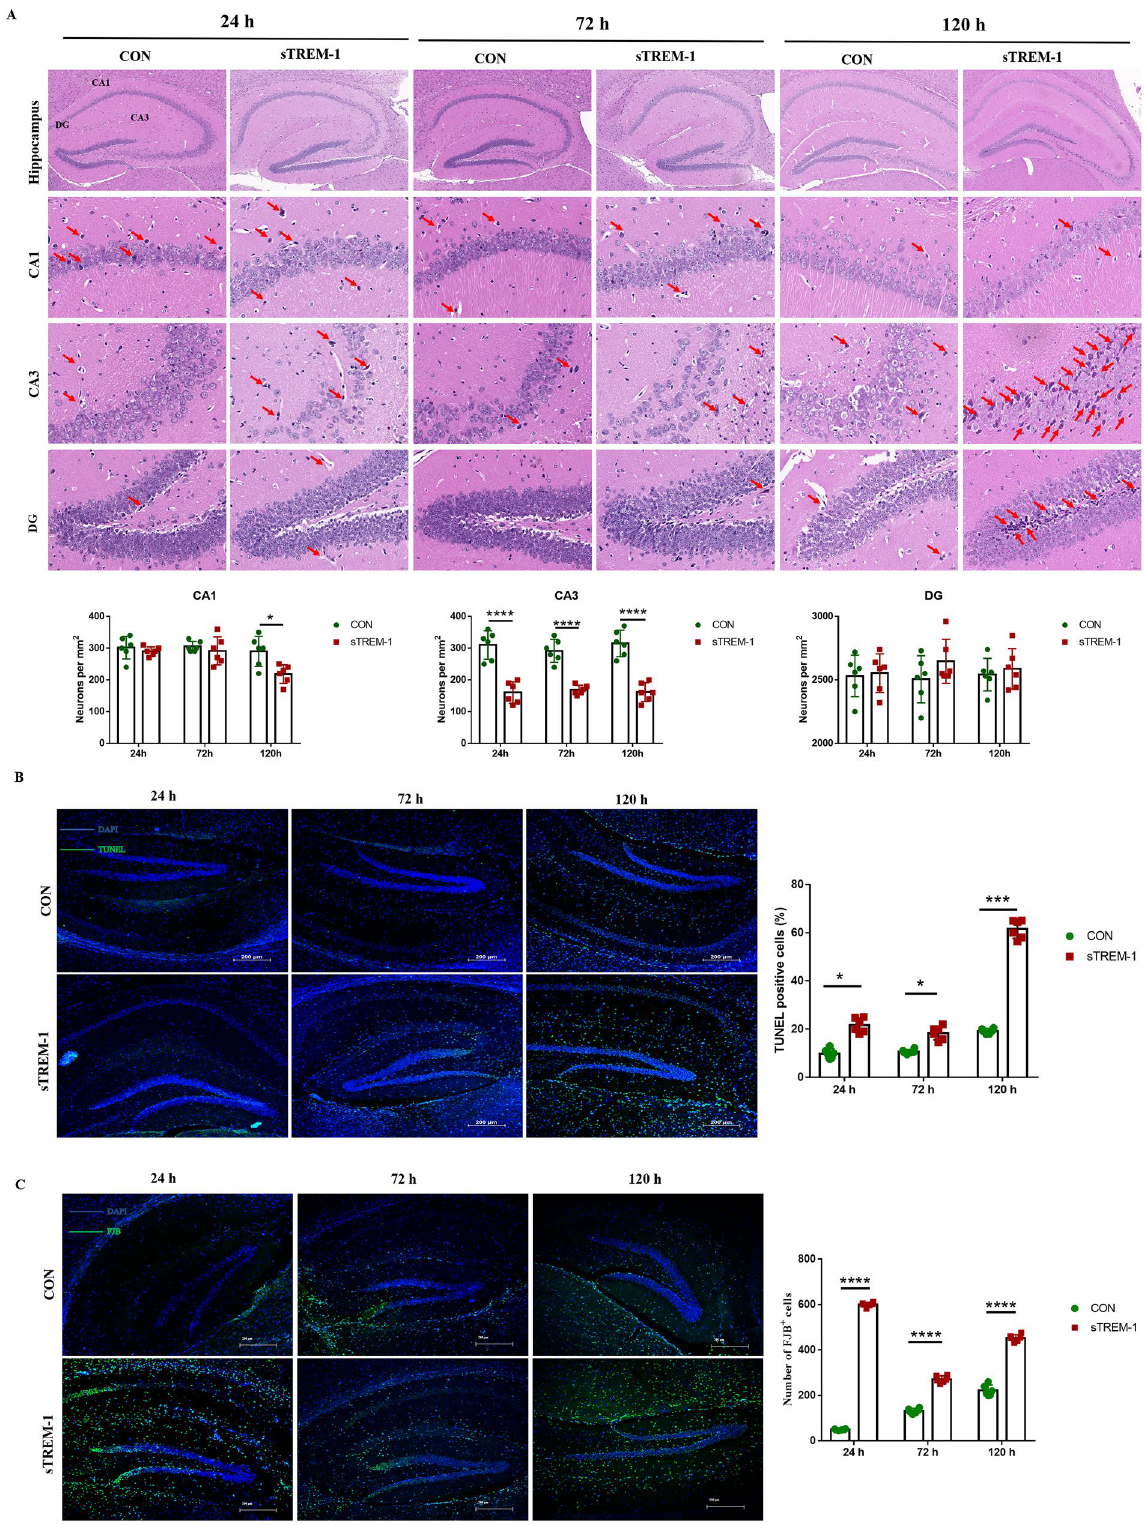
Figure 1. sTREM-1 induces hippocampal neurons damage in mice of mice. (A) H&E staining was used to observe the morphological changes of neurons in the CA1, CA3, and DG areas of the mouse hippocampus, n = 6. (B) Representative fluorescence image of hippocampal TUNEL staining of mice; scale bar is 200 μm; and the statistical analysis of the percentage of TUNEL positive cells in the entire hippocampus, n = 6. (C) Representative fluorescent images of hippocampal FJB staining of mice, scale bar is 200 μm; and the number of FJB positive cells in the entire hippocampus, n = 6. Data are presented as means ± SEM of at least three separate experiments, * P < 0.05, *** P < 0.001, **** P <